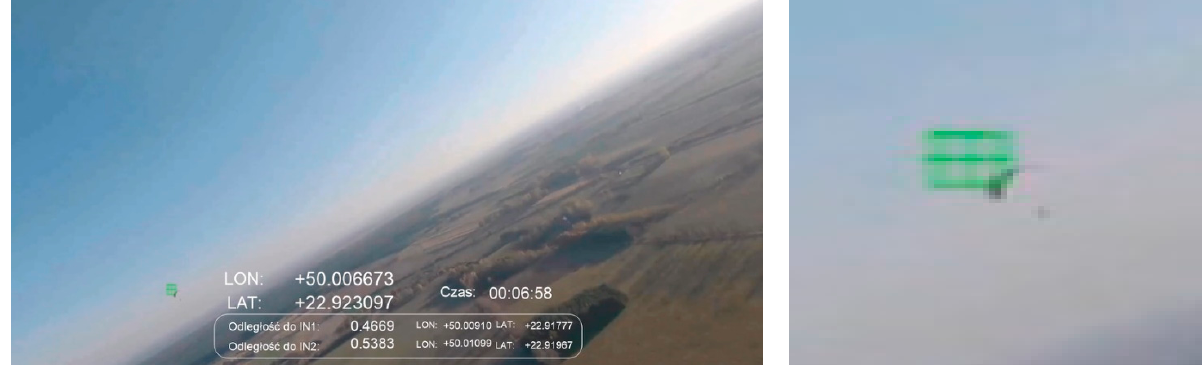
Figure 13. Detection of paraglider; afternoon, sun ~90 degrees to the right, altitude ~150 m, distance to intruder: 466 m.